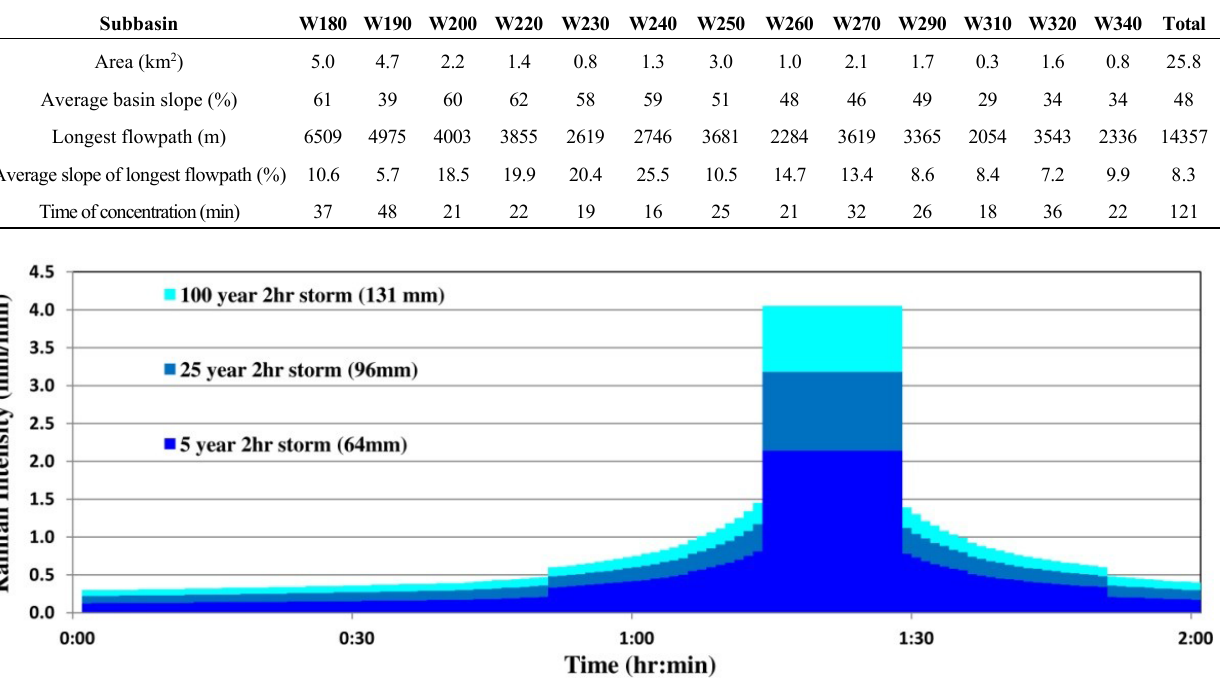
Figure 12. Design storms used as input for rainfall-runoff